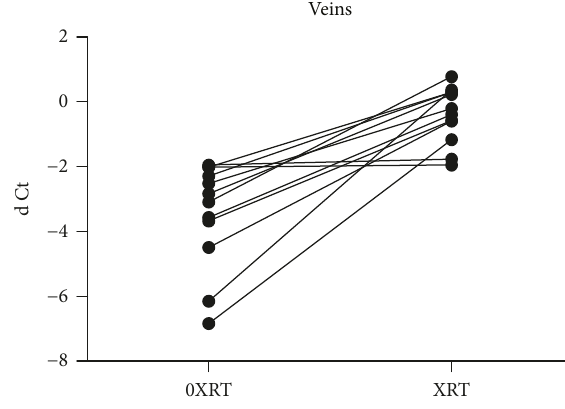
Figure 2: Serpine1 gene (PAI-1) expression is higher in irradiated veins (XRT) vs unirradiated veins (0XRT; ddCt), in relation to GAPDH (dCt), p < 0 001